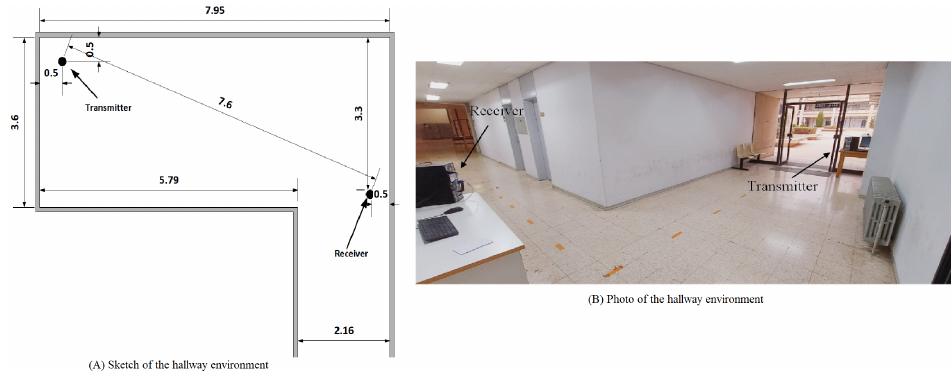
Figure 5. The hallway environment used for data collection. All dimensions are in meters.